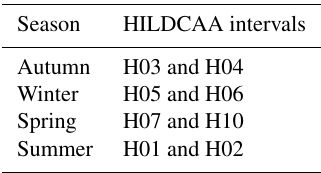
Table 2. Seasonal classification of HILDCAA intervals (according to the seasons in the Southern